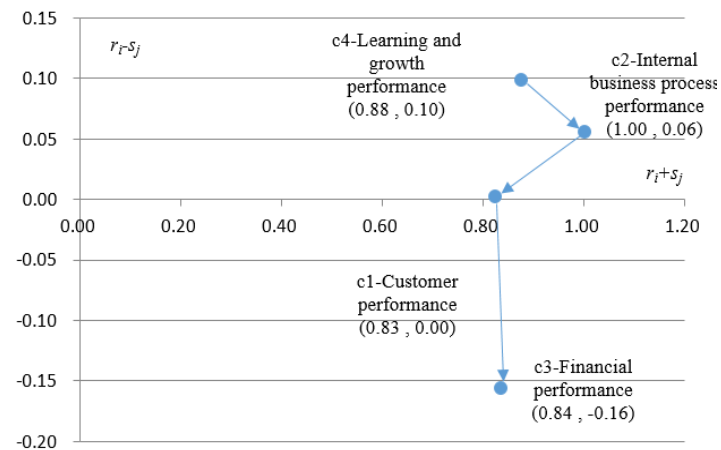
Figure 5. Dimension B–criterion of IRM.